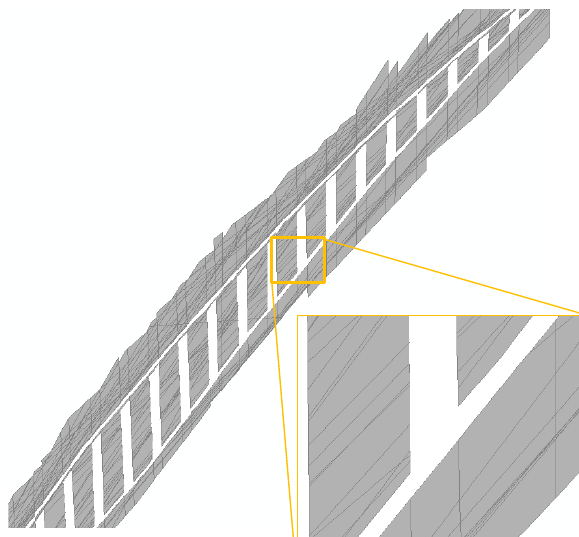
Figure 17. Traffic marking extraction calculated with